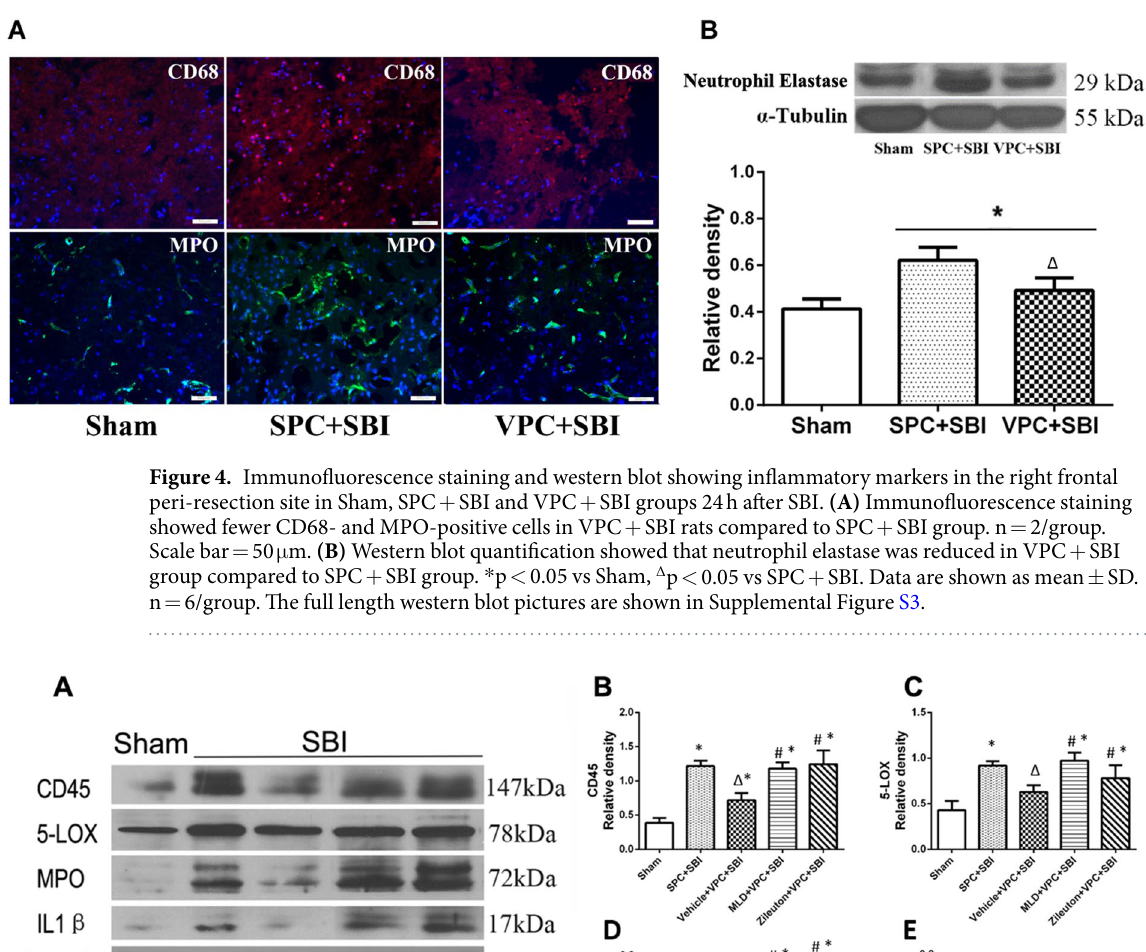
subcutaneous skin injection site. (3) VPC reduced neutrophil infiltration and inflammatory cytokine release in the peri-resection brain tissue 24 h after SBI. (4) The expression of 5-LOX in the peri-resection brain tissue was elevated 24 h after SBI which was reduced with VPC. (5) The selective PLA2 inhibitor, Manoalide and 5-LOX inhibitor, Zileuton reversed the protective effects of VPC against SBI-induced neuroinflammation 24 h after SBI. (6) The VPC regime used in this study including the dose, timing and subcutaneous administration of the venom did not elicit any significant adverse cardiotoxic effects. We observed that 3 days of venom preconditioning reduced brain edema, neuroinflammation and improved post-operative neurological function after SBI. Venom preconditioning induced a mild peripheral inflammatory response at the subcutaneous injection site on the skin which presented with redness and edema. Previous stud- ies show that cobra venom toxins have high affinity for tissues at the site of injection 24 . The injection associated mechanical injury and hemolytic components from the snake venom causes minor bleeding leading to Ca 2 + release and leukocyte extravasation from blood vessels into the skin injection site. In the presence of Ca 2 + , venom